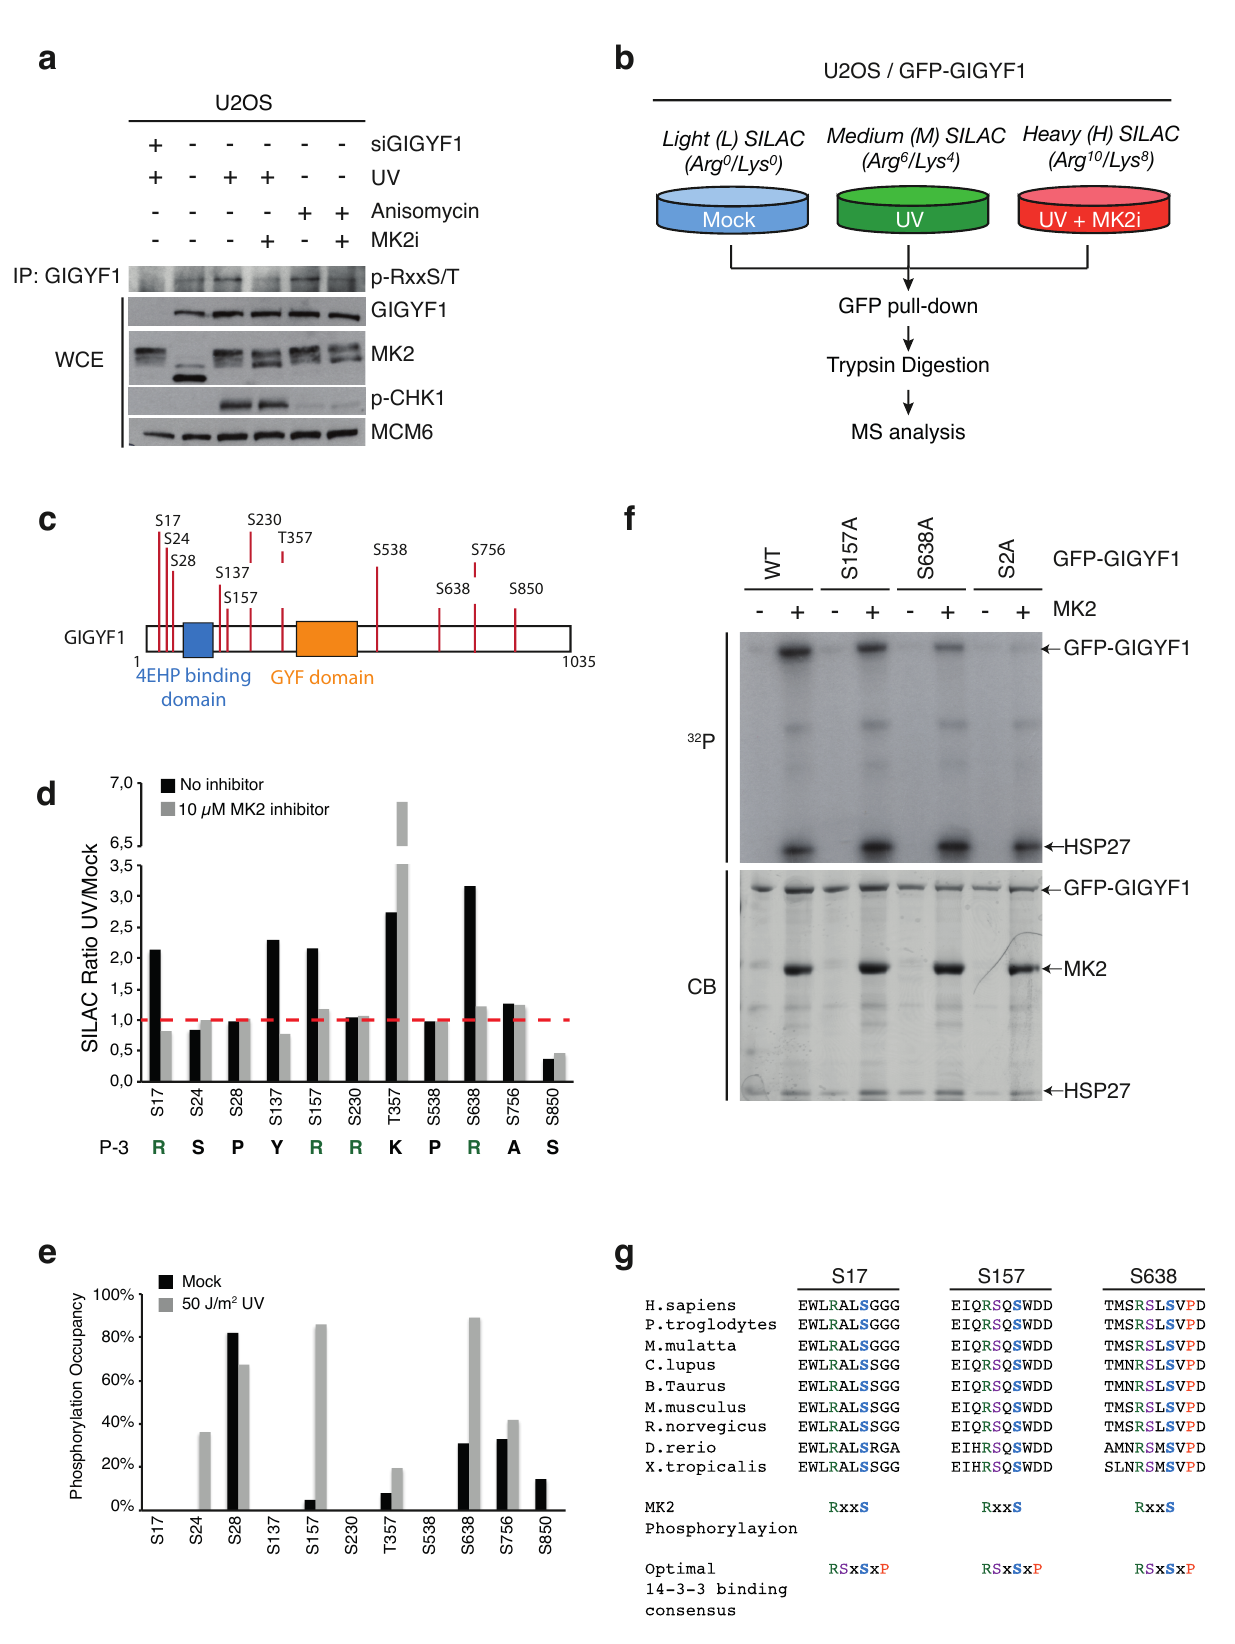
Figure 2. MK2 phosphorylation and 14–3–3 binding of GIGYF1. ( a ). U2OS cells transfected with GIGYF1 siRNA were pre-treated with MK2 inhibitor (MK2i, 0.5 h) and treated with UV (50 J/m 2 , 1 h recovery) or anisomycin (1 h) as indicated. GIGYF1 immuno-precipitated material (IP: GIGYF1) and whole cell extracts (WCE) were analyzed by immunoblotting